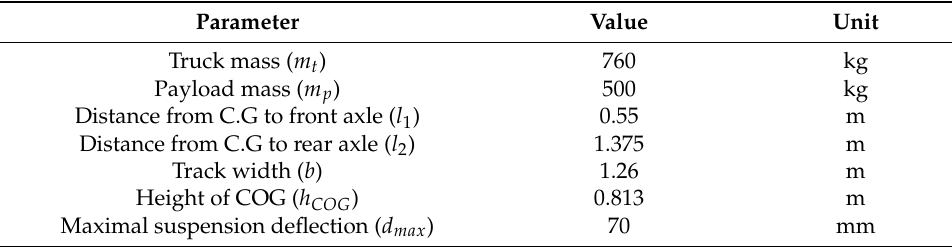
Table 4. Vehicle